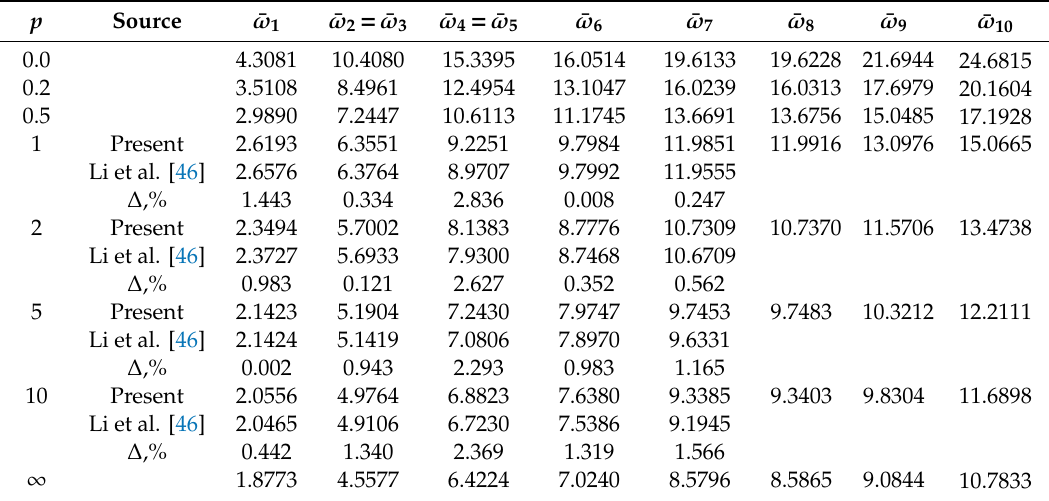
Table 5. The first ten nondimensional frequencies of SSSS SUS304 / Si 3 Ni 4 functionally graded square plates thermally loaded by the nonlinear temperature rise as shown in Figure 5.